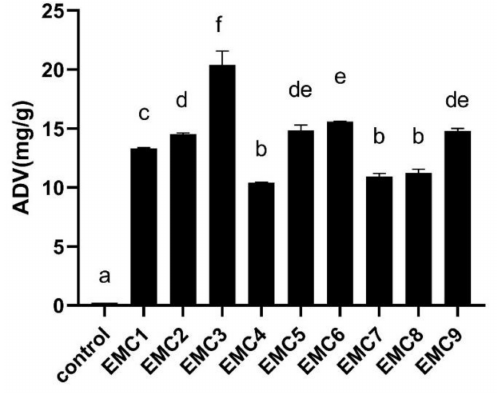
Figure 1. Individual acid degree values (ADV) (mg/g on a sample weight basis) of the proteolyzed product (control) and final EMCs (EMC1-EMC9). a–f: Different letters in ADV indicate significant statistical differences (Tukey’s Test, p <